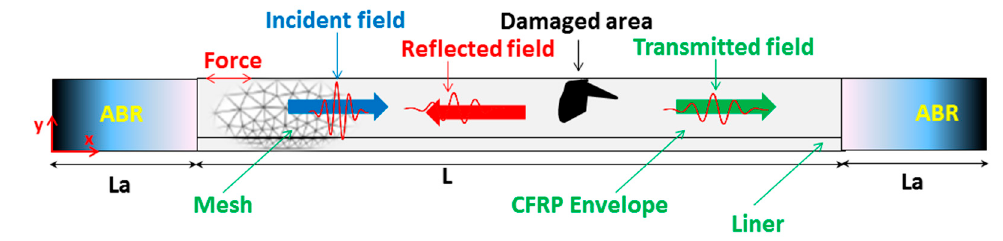
Figure 3. Schematic of the Finite Element simulation model (ABR: Absorbing Region of a length La).